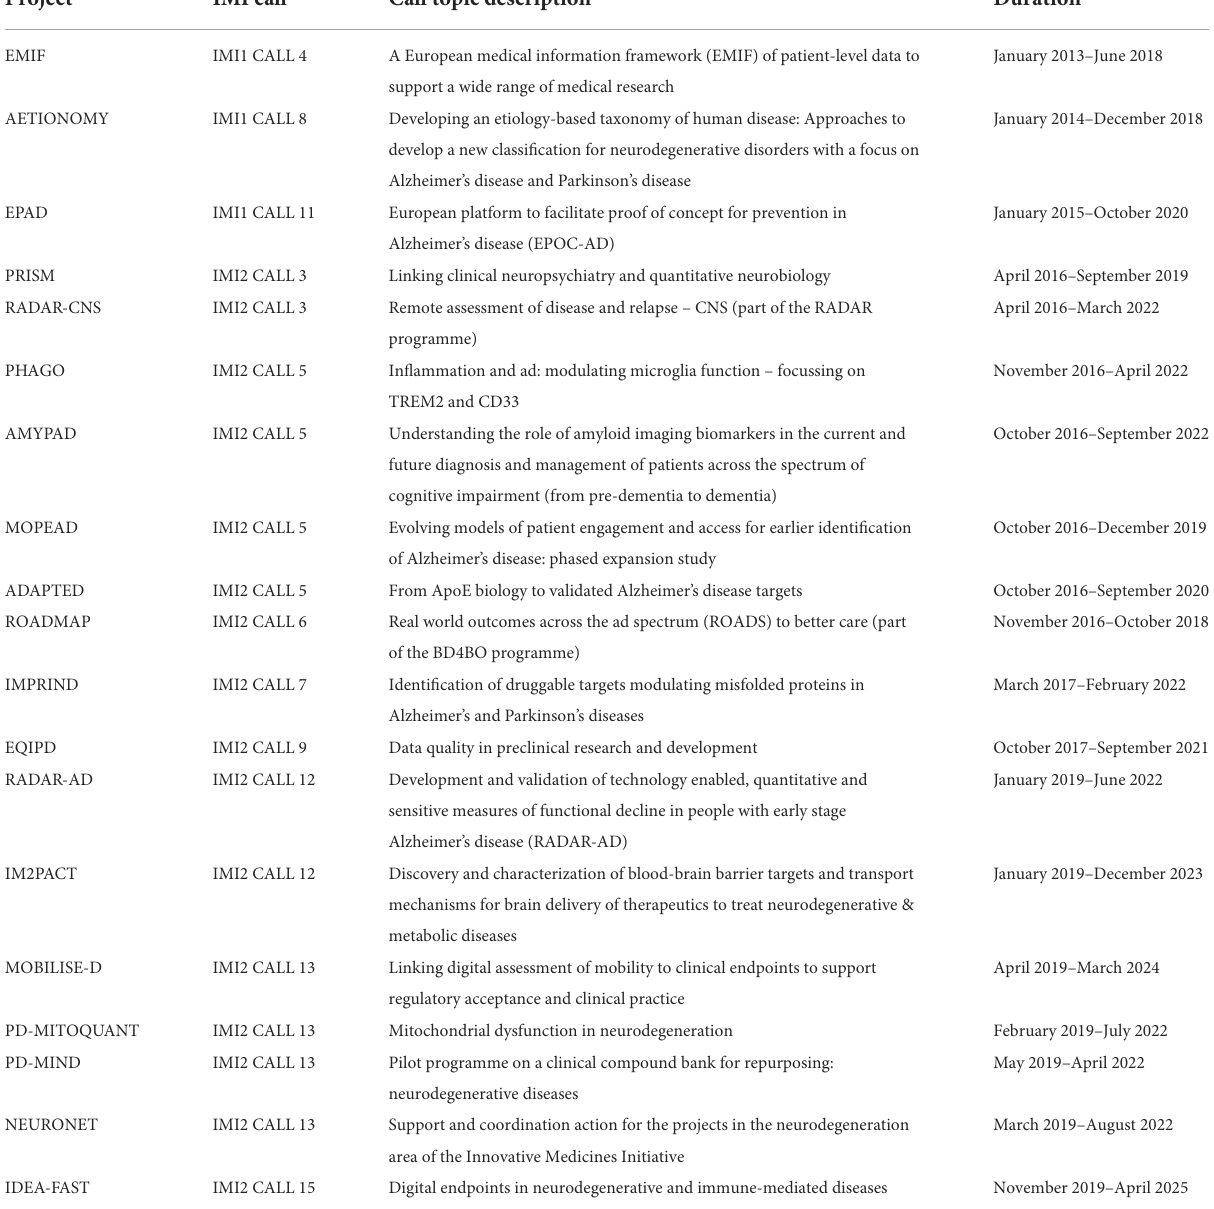
TABLE 1 IMI neurodegenerative disease projects and